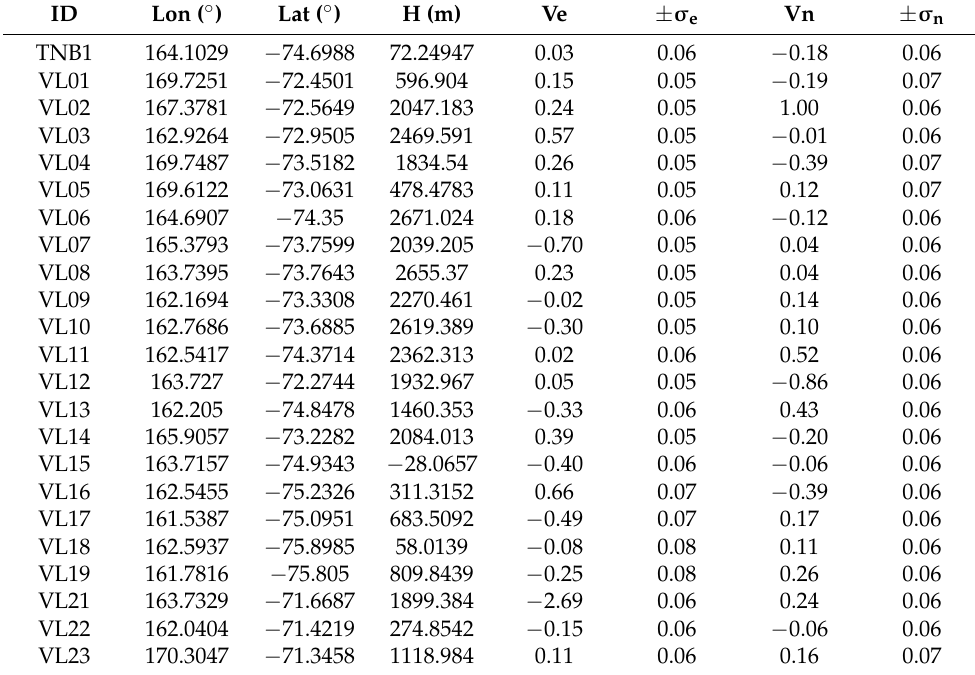
Table 2. Coordinates and relative velocities of GNSS stations adopted to evaluate the strain rate field of VL. These rates were obtained using relative velocities obtained with VLNDEF20 Euler Pole estimation. TNB1 and VLXX sites are VLNDEF stations; the others are POLENET. Velocities and errors are in